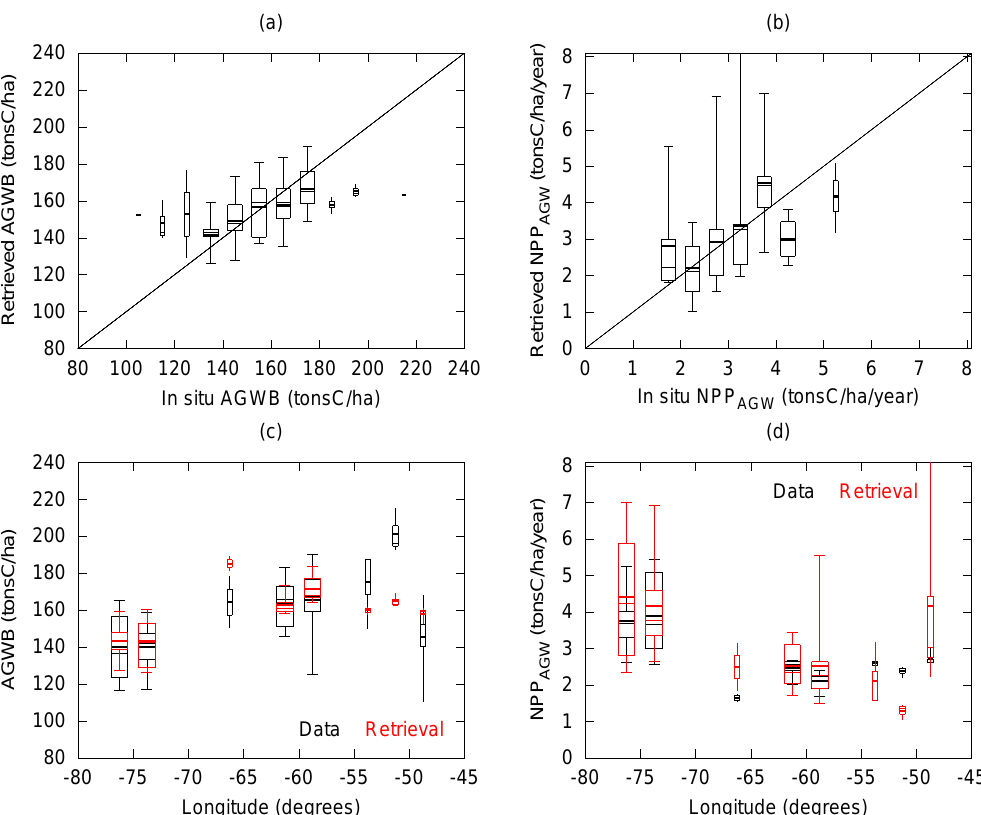
Fig. 7. Impact of introducing t residence = f (NPP AGW ). (a) and (c) : AGWB retrieved from ground measurements of NPP AGW with t residence derived from the best fit in Fig. 5 . (b) and (d) : NPP AGW retrieved from ground measurements of AGWB with t residence derived from the best fit in Fig. 5. For panels (a) to (d), we excluded nine points (out of 72) for which annual precipitation were lower than 1500mm. (c) and (d) show longitudinal gradients of respectively AGWB and NPP AGW for sites with latitudes between 10 ◦ S and 3 ◦ N.